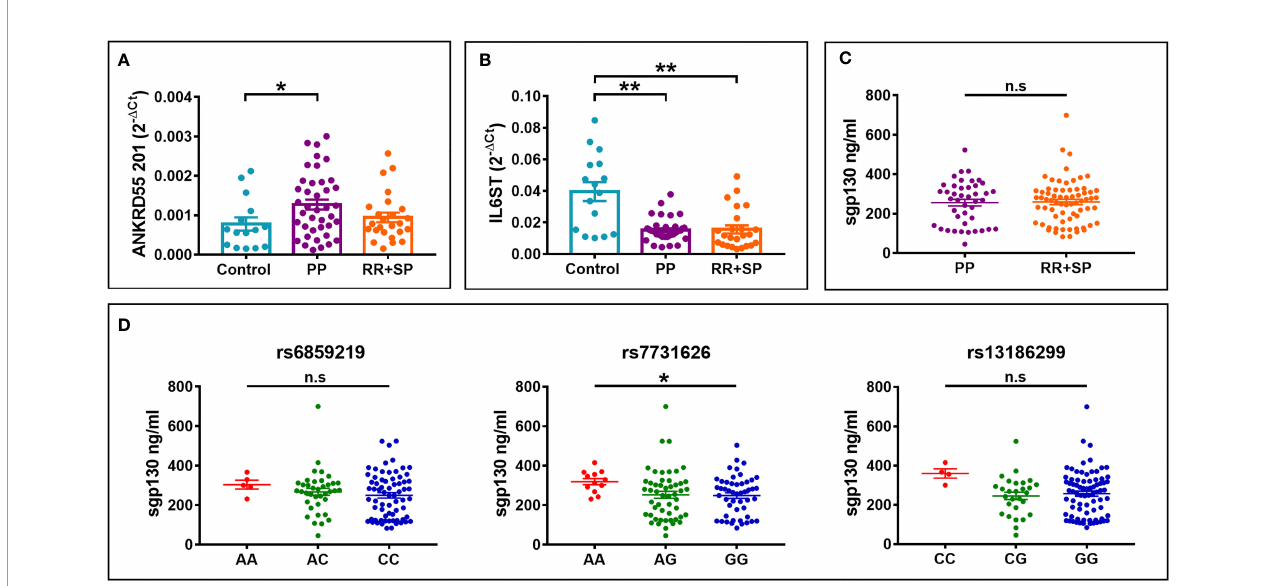
FIGURE 8 | Differential (A) ANKRD55 and (B) IL6ST gene expression levels in immature moDC according to clinical course of MS, PP, or RR+SP, as measured by qPCR. Mean ± SEM; n = 80, Cohorts 1 and 2, Kruskal – Wallis test (followed by Dunn ’ s multiple comparison test). (C) Levels of serum sgp130 protein measured by ELISA in PP MS and RR+SP MS. Mean ± SEM; n = 112, Cohorts 1, 2, and 3, Mann – Whitney test (n.s.). (D) Serum sgp130 levels in MS patients from panel (C) strati fi ed for rs6859219, rs7731626, or rs13186299 genotype. Kruskal – Wallis test (followed by Dunn ’ s multiple comparison test). * p ≤ 0.05, ** p ≤ 0.01. n.s., not signi fi